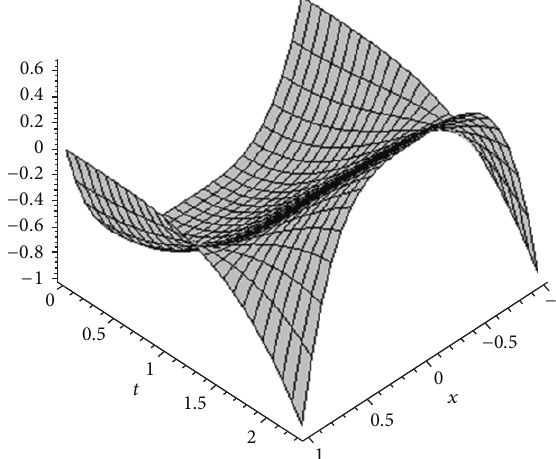
Figure 1: The graphic of the function 𝑢 1 (𝑡,𝑥) in the test problem (32).